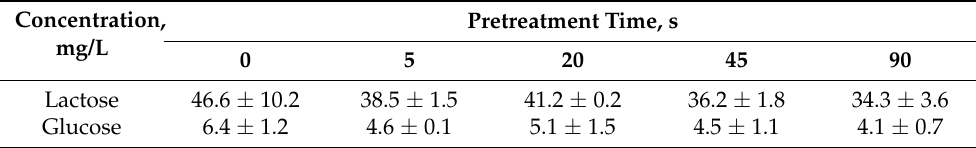
Table 2. The content of sugars in CW after pretreatment in VLA.